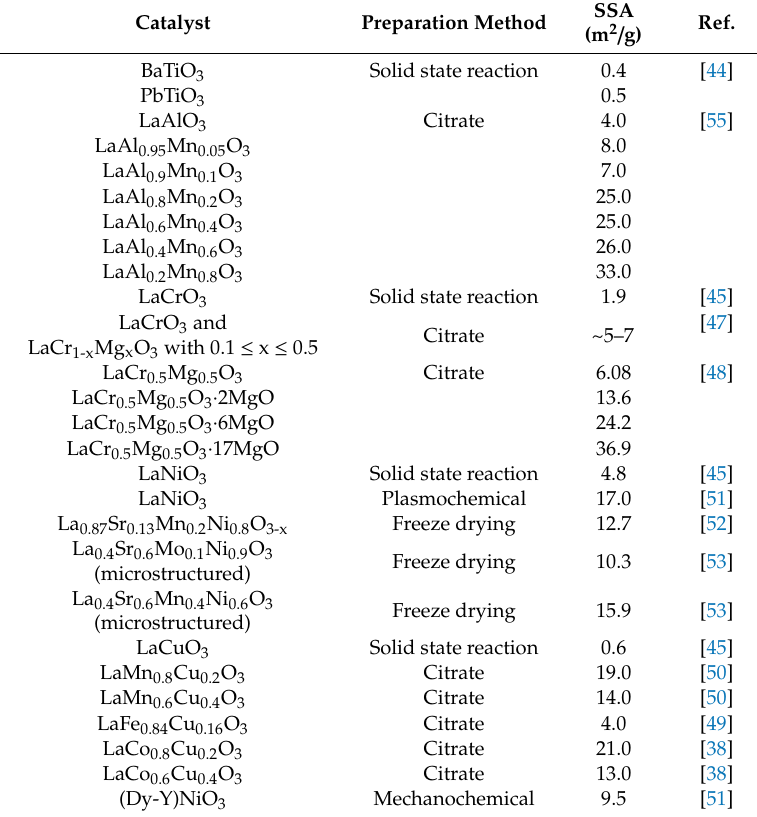
Table 1. The influence of the synthesis method on the specific surface area (SSA) of di ff erent perovskite